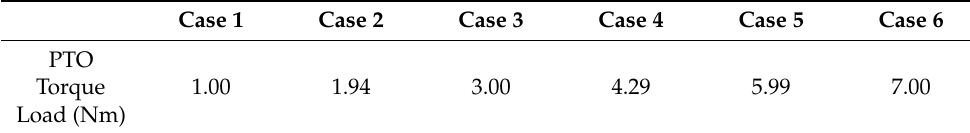
Table 3. Input PTO load